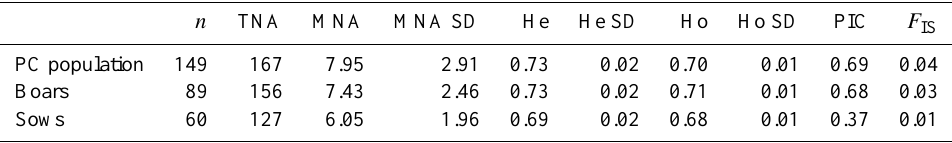
Table 2. Microsatellite diversity in PC breed and comparison between sex. n TNA MNA MNA SD He He SD Ho Ho SD PIC F IS PC population 149